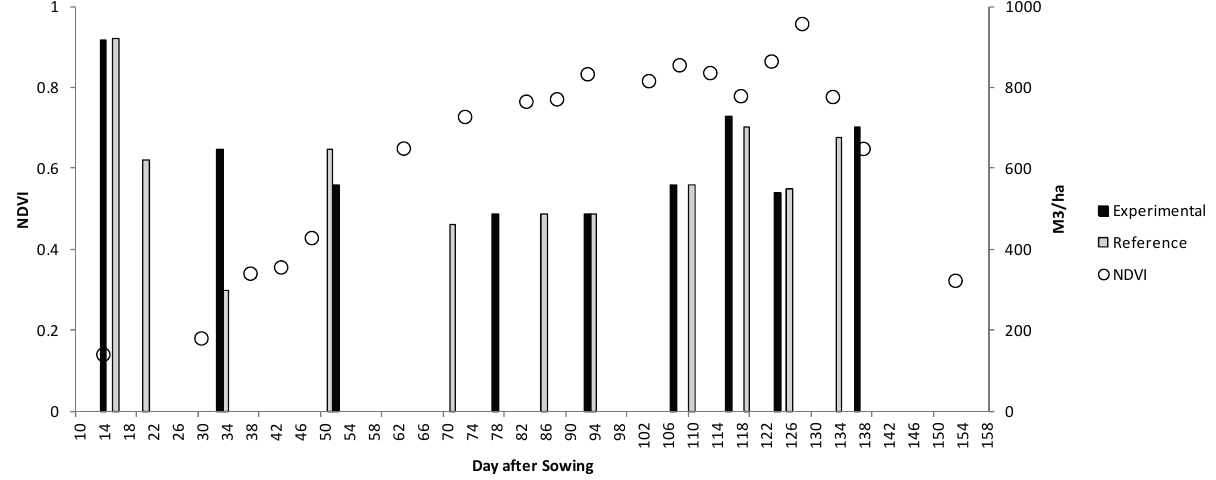
Figure 9. Comparison of irrigation events between the two plots. Time intervals between events are indicated in the same figure. NDVI is for the experimental